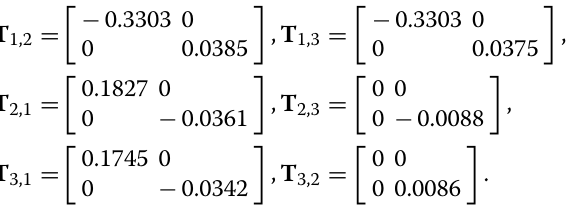
stable under arbitrary switching signal. In order to check the boundedness of input u k , we solve for the CQLF for A 1 , A 2 , and A 3 . In this case, the result reveals that the orig- inal SHS is not stable (falls into scenario 1 in Section 4.3).